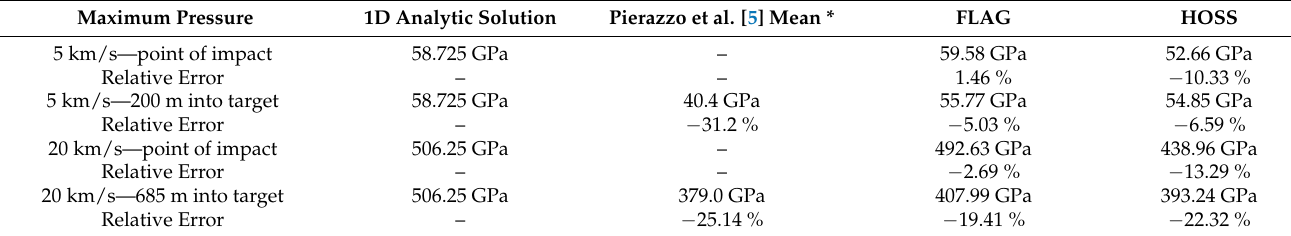
Table 3. Maximum pressures from 2D simulations in FLAG and HOSS compared to the theoretical maximum. These values are also compared to the mean of the values reported in Pierazzo et al. [5] by various codes. The relative error is reported with respect to the 1D analytical solution.